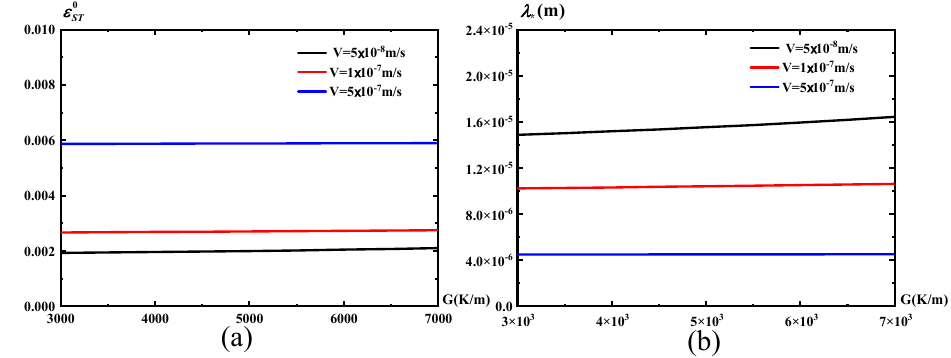
( n = 0 ) of versus G for the typical case ST